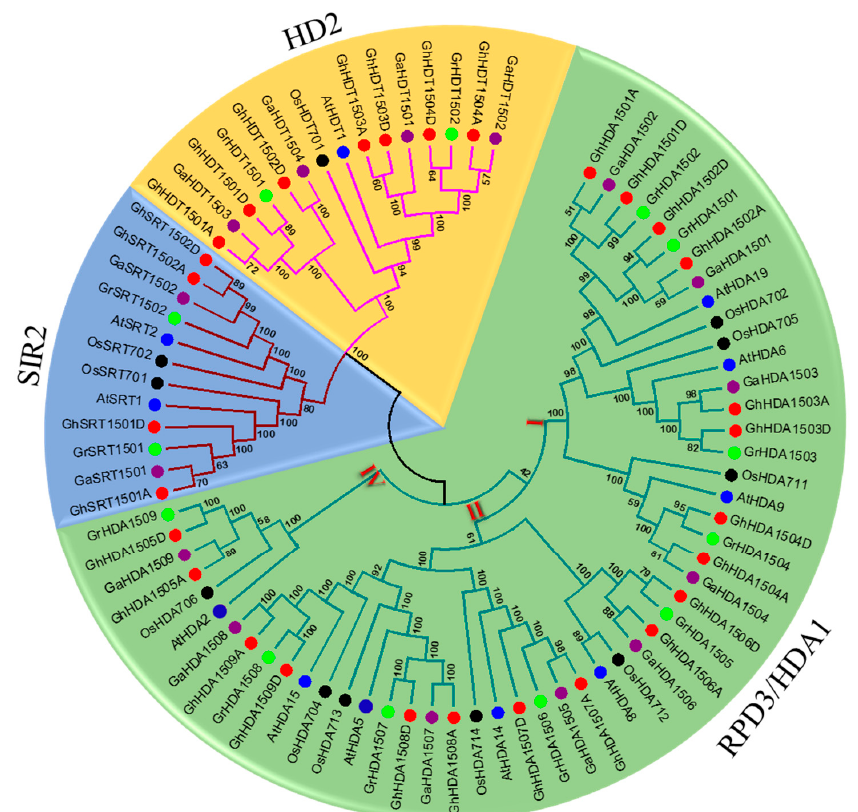
Figure 1. Phylogenetic relationships of histone deacetylases (HDACs) from G. hirsutum , G. raimondii , G. arboretum , Arabidopsis thaliana and Oryza sativa . The unrooted phylogenetic tree was constructed with MEGA 6 using the neighbor-joining method and the bootstrap analysis was performed with 1000 replicates. The HDACs from G. hirsutum , G. raimondii , G. arboretum , Arabidopsis thaliana and Oryza sativa are marked with red, green, purple, blue and black dots, respectively. The branches of each subgroup are indicated in a specific color. RPD3: reduced potassium dependency 3, SIR2: silent